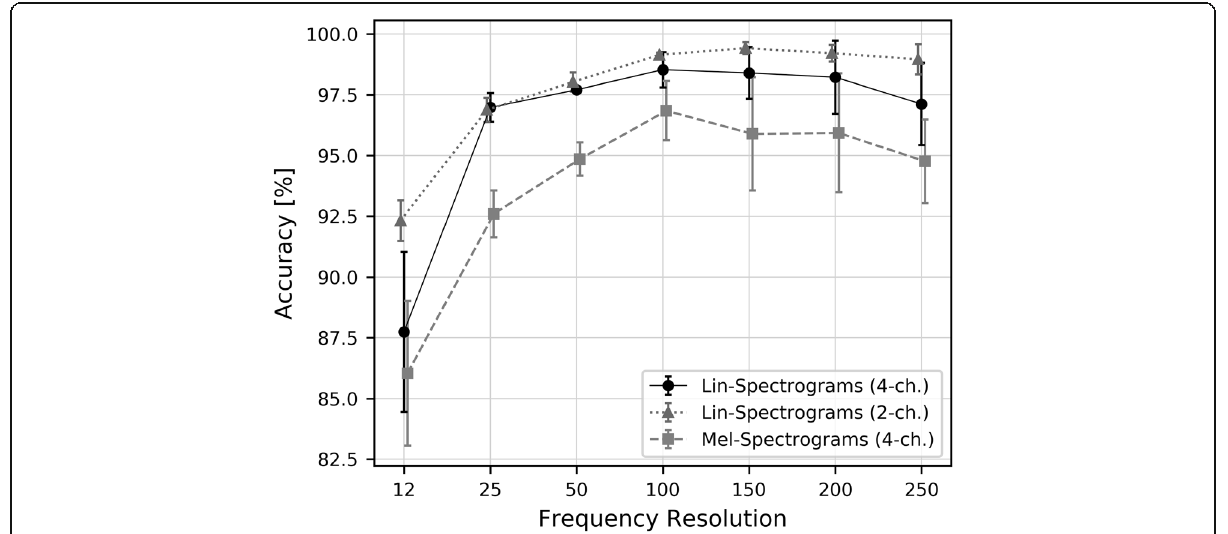
Fig. 10 Influence of the frequency resolution and type of the spectrograms on the discrimination results using CNN. Error bars denote standard